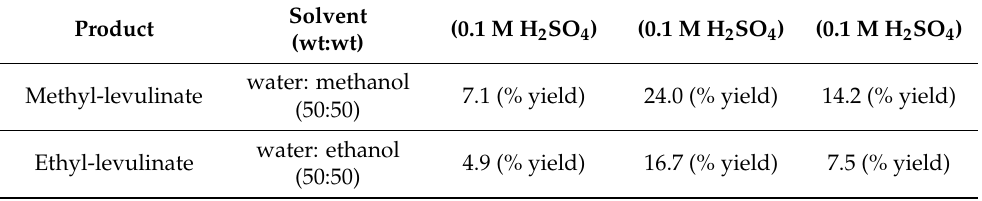
Table 5. Effect of acid conditions on the preparation of methyl-levulinate and ethyl-levulinate starting from OPW by using HTC process (Reaction conditions: 20 g of OPW; temperature: 180 ◦ C; time: 60 min; autogenous pressure; stirring: 600